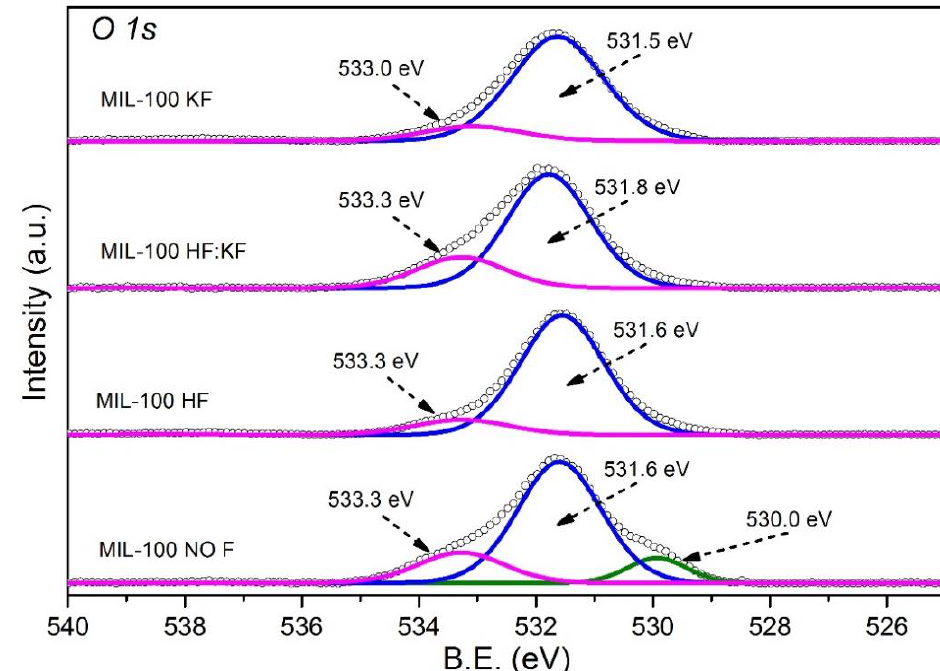
Figure A3. XPS spectra of the O 1s core level for all samples as prepared.